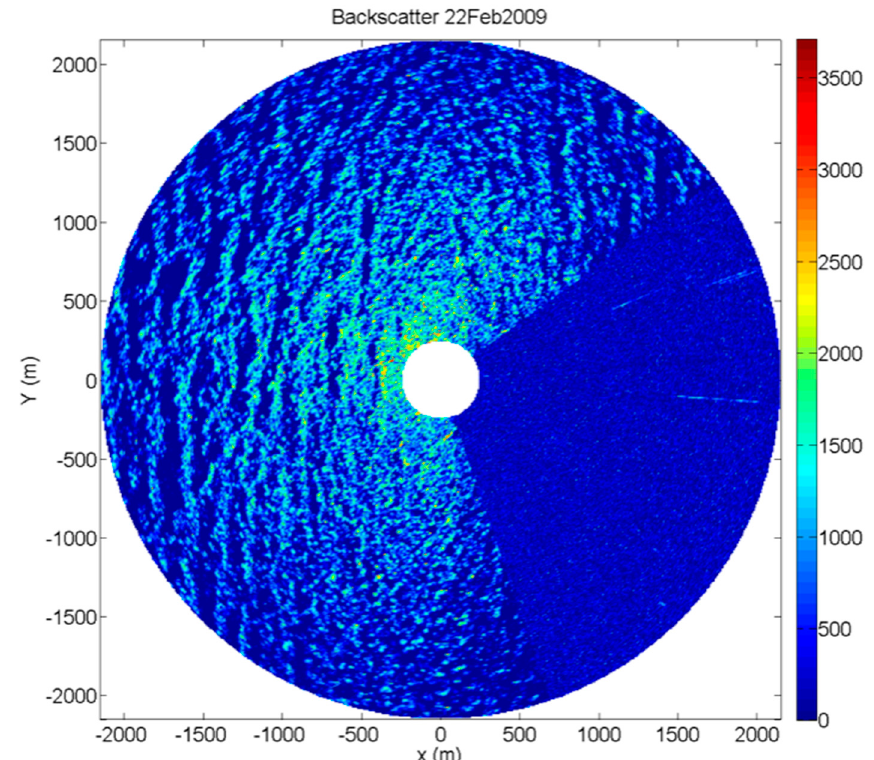
Figure 31. Radar measurements reported by Sutherland and Melville [62,63].